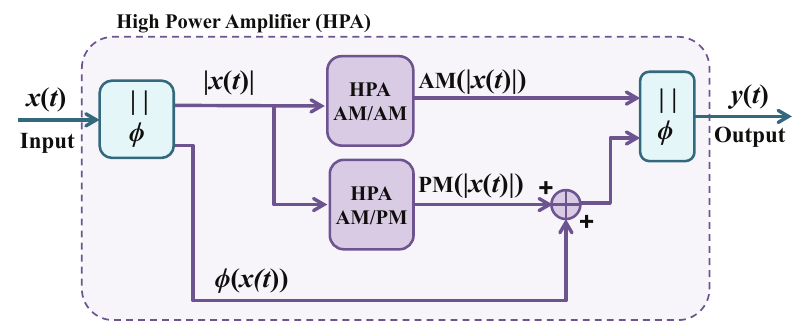
Figure 1. HPA’s operating